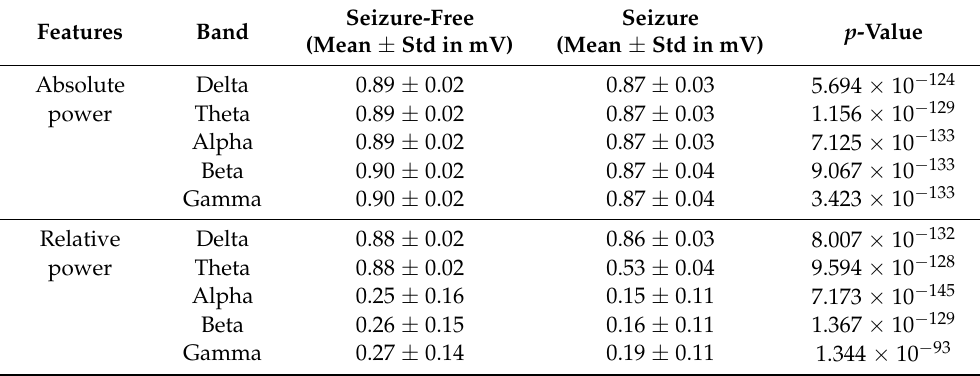
Table 4. Range of values of the spectral power measures for the two classes of seizure and seizure-free. The lowest p -value of 7.173 × 10 − 145 for the relative power at the alpha band indicates the great discrimination capability of this feature in characterizing seizure records.